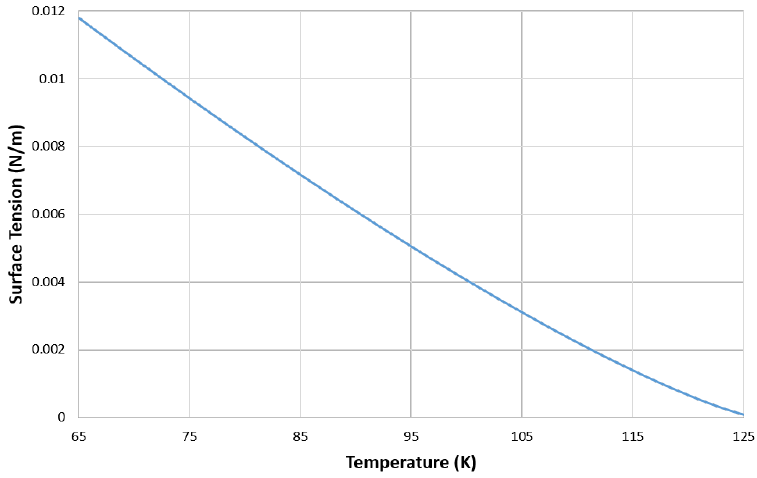
Figure 5. Surface tension plot of nitrogen against temperature from NIST